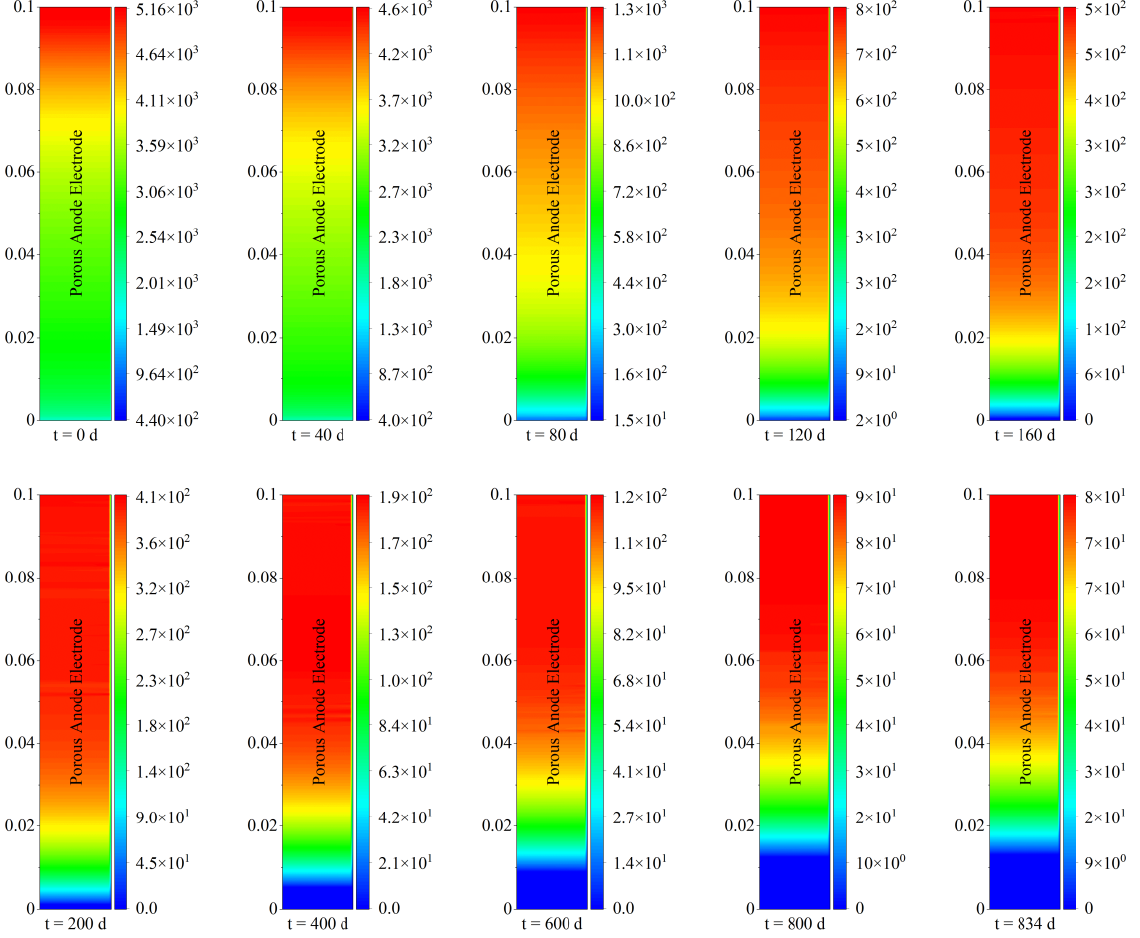
Figure 11. The spatial and temporal evolution of current density (A/m 2 ) within the porous anode electrode of the solid oxide fuel cell during 20,000 h of steady − state operation.